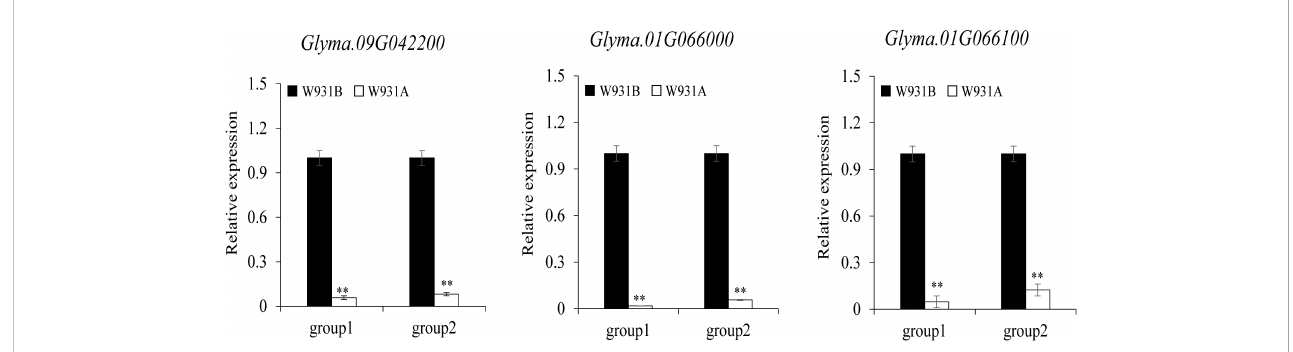
FIGURE 3 Expression levels of candidate genes with the “ pectinesterase ” molecular function annotation as determined with quantitative reverse transcription (qRT)- PCR. Relative expression levels are shown for the uninucleate microspore (UM) stage (group1) and for the binucleate pollen (BP) stage